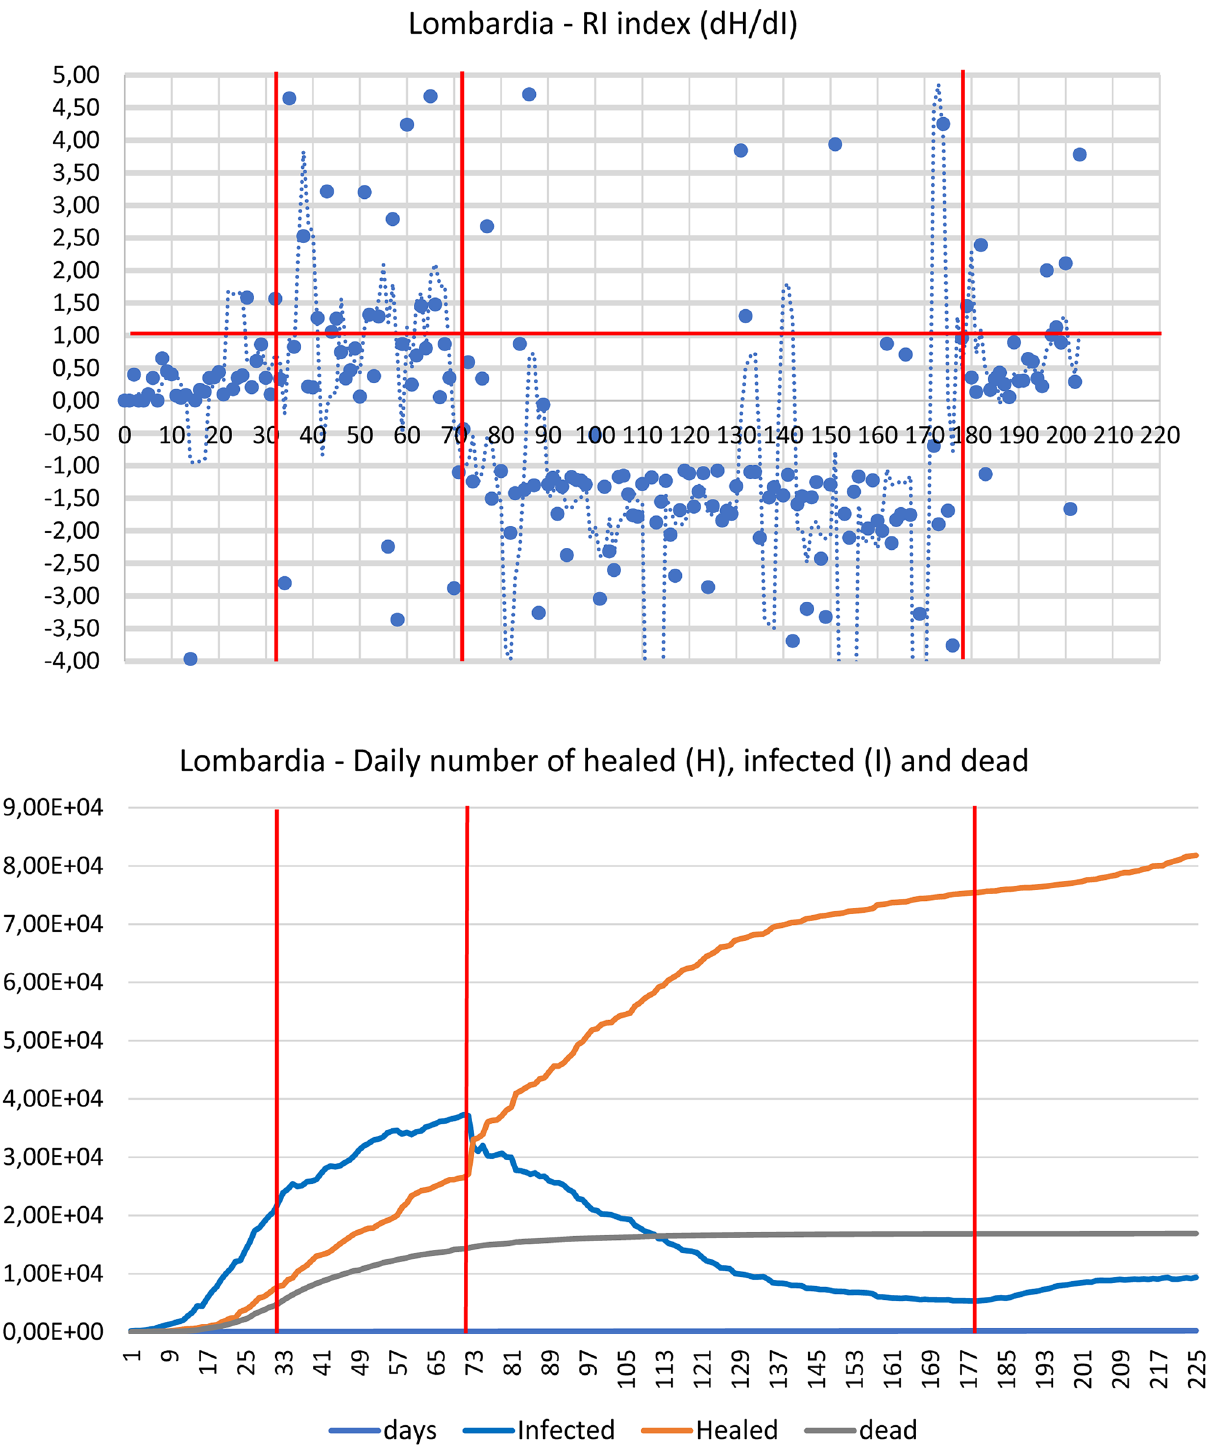
Figure 1. The figure reports for both Lombardia, Italy without Lombardia, and Italy the dH/dI (RI) index daily variation (A,C,E) , the cumulative Dead and Healed count together with the Infected daily number. and the dH and dI daily variation (B,D,F) . The graphs are subdivided into five temporal windows corresponding to the Beginning, Rising, Plateau and ‘Second Wave’ phases respectively (see text). The presence of a ‘tipping point’ of epidemic is evident around 20 of April in all the different representations as intersection of ‘rising’ healed and ‘declining’ infected curves. The only (partial) exception is the Lombardia dH vs. dI plot were the tipping point is blurred between April and May. This behaviour is consistent to the much higher variability of RI index of Lombardia, pointing to the presence of ‘super-spreaders’